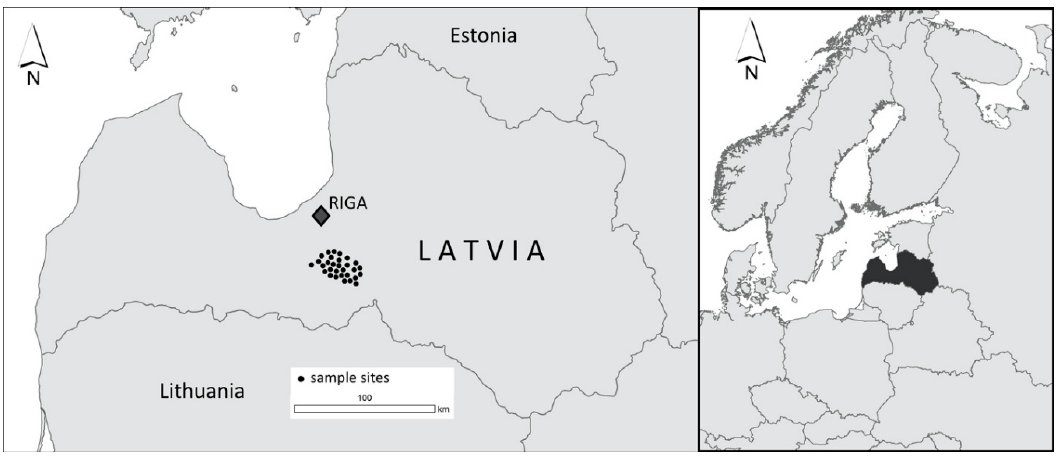
Figure 1. Locations of study sites in Latvia.